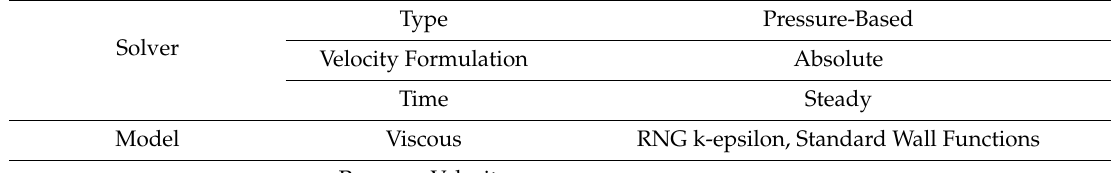
Table 2. [51]. Settings of the CFD analysis.